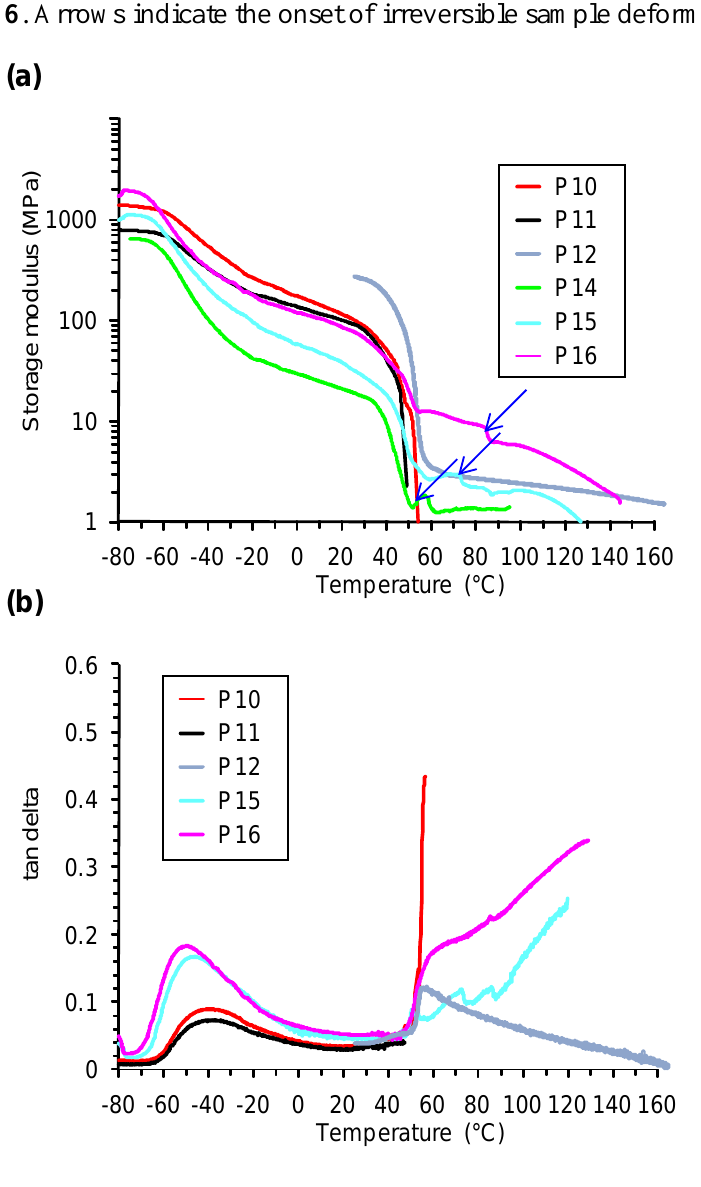
Figure 4. Plot of (a) the storage modulus and (b) tan δ as a function of temperature for polymers P10 – P16 . Arrows indicate the onset of irreversible sample